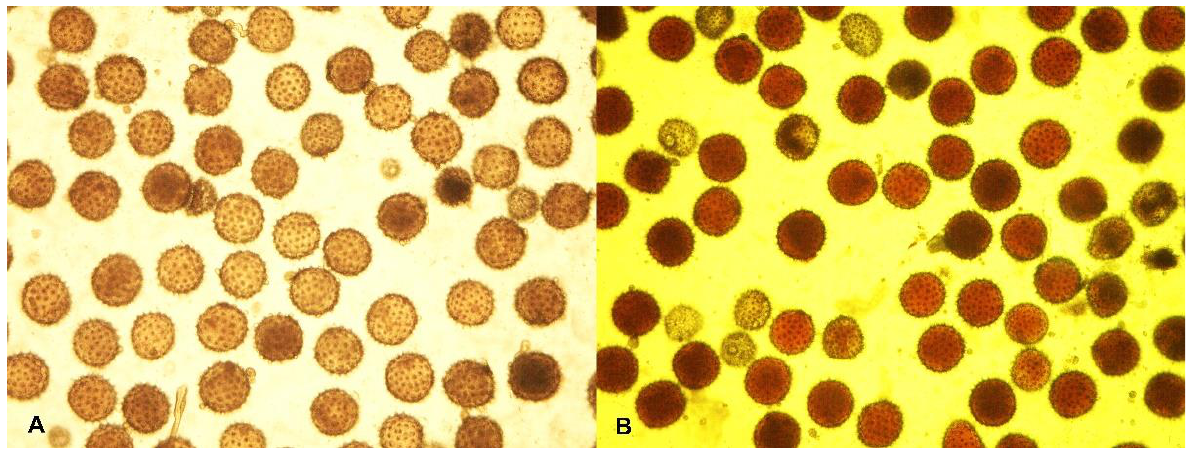
Figure 5. Pollen fertility: ( A ) photoperiod-sensitive wild-type G. hirsutum subsp. purpurascens (var. El-Salvador) — 94.82 ± 0.52%; ( B ) day-neutral mutant line (var. Kupaysin) — 88.51 ± 0.75.